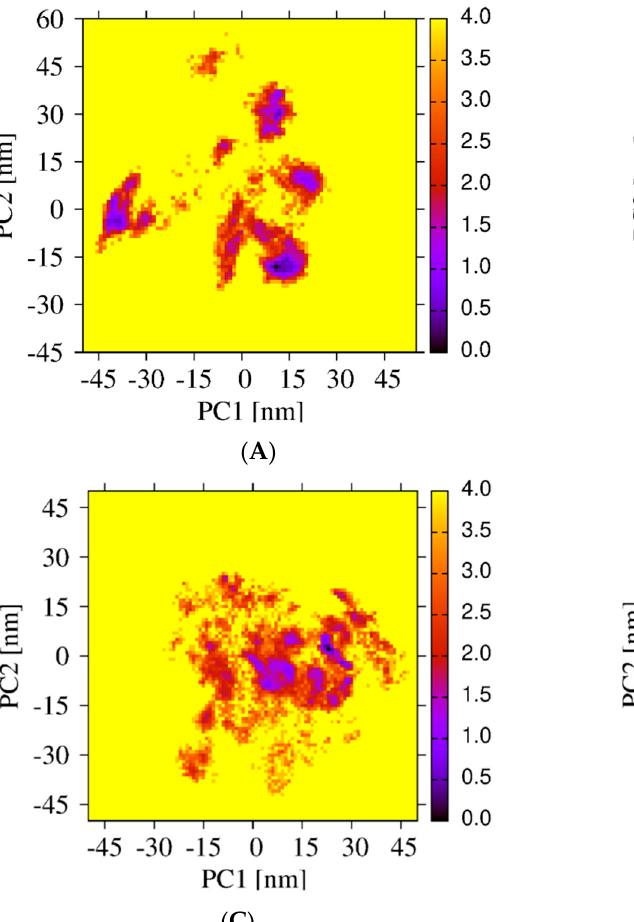
Figure 2. REST2 Sampling. ( A ) Overlap of the total potential energies for replicas 1 to 16. ( B , C ) Ex- changes of coordinates as a function of simulation time of replica 1 and replica 16, respectively.